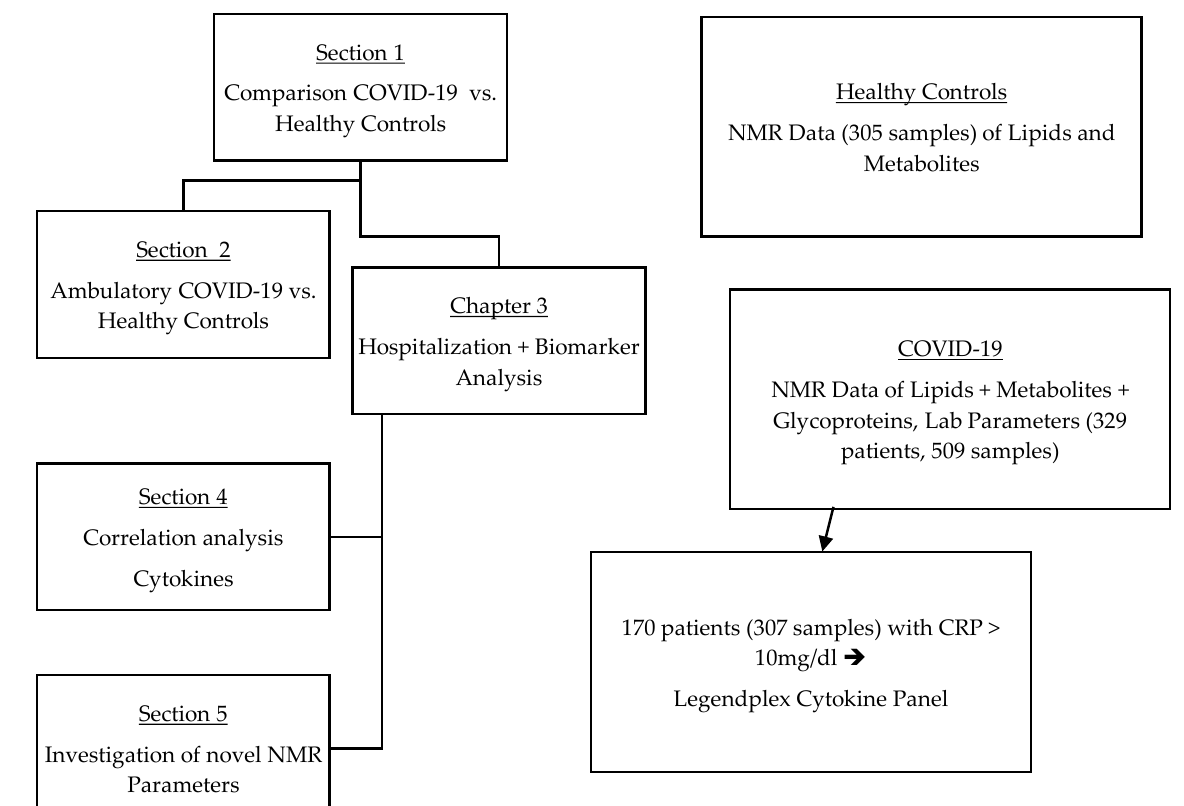
Figure 1. Consort diagram showing an overview of the performed analyses and the available data (after quality